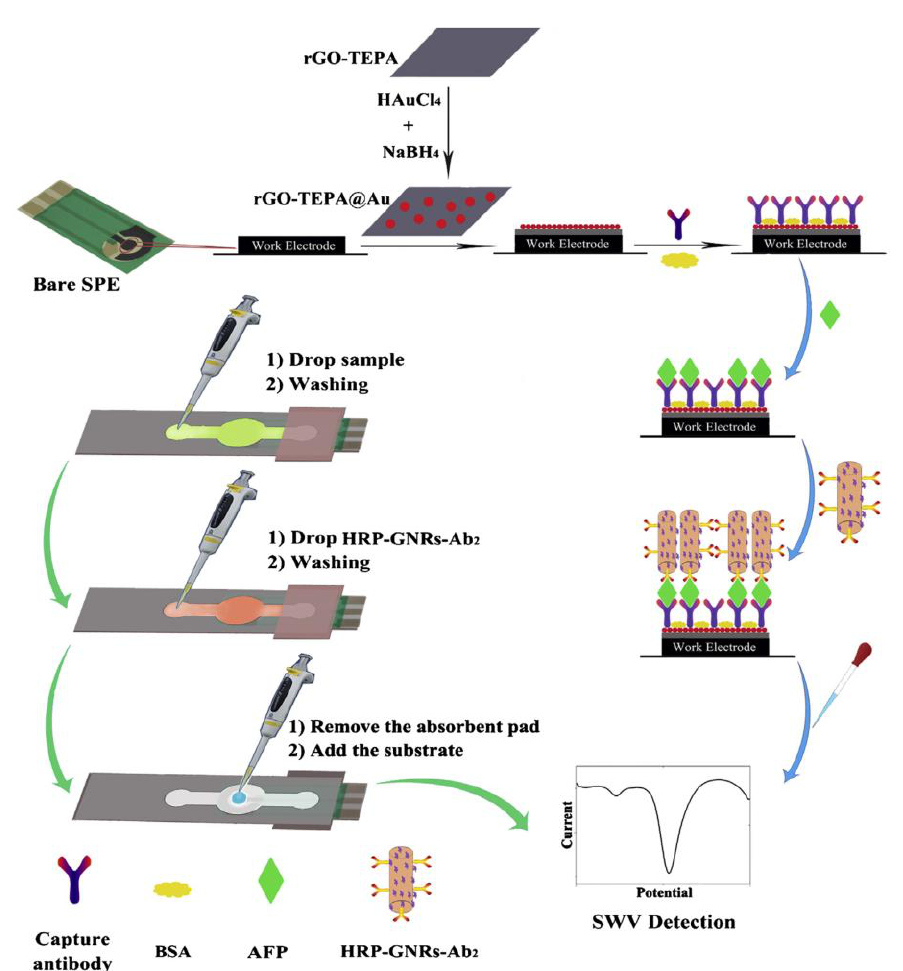
Figure 5. Schematic displays of the modification and assay procedure for the implementation of an immunosensor for the determination of alpha-fetoprotein (AFP) using paper-based microfluidic channels to integrate sampling, detection and adsorption zones, and a reduced graphene oxide (rGO)-tetraethylene pentamine (TEPA) / AuNPs nanocomposite for immobilization of specific AFP antibodies. Reproduced with permission of Elsevier